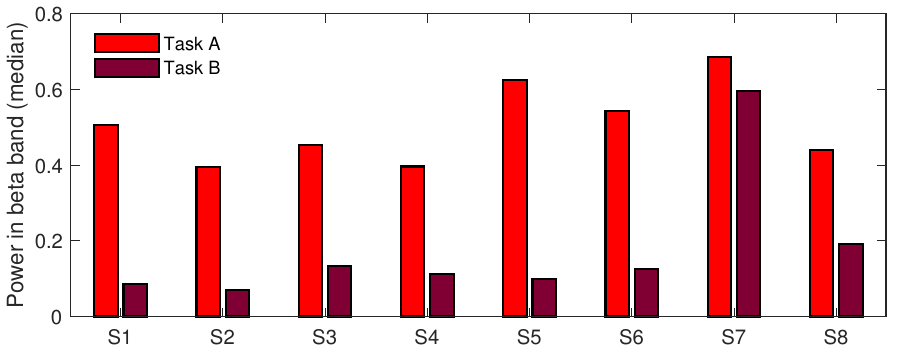
Figure 7. Task A vs. Task B—difference in medians across subjects for the STRESS condition; S: